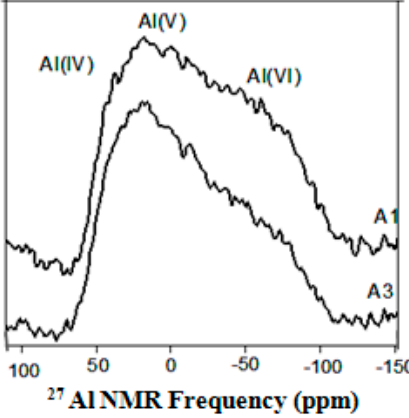
Figure 25. 27 Al magic-angle spinning (MAS) NMR study of the doping region of Al in two preform samples of EDF: A1 and A3.